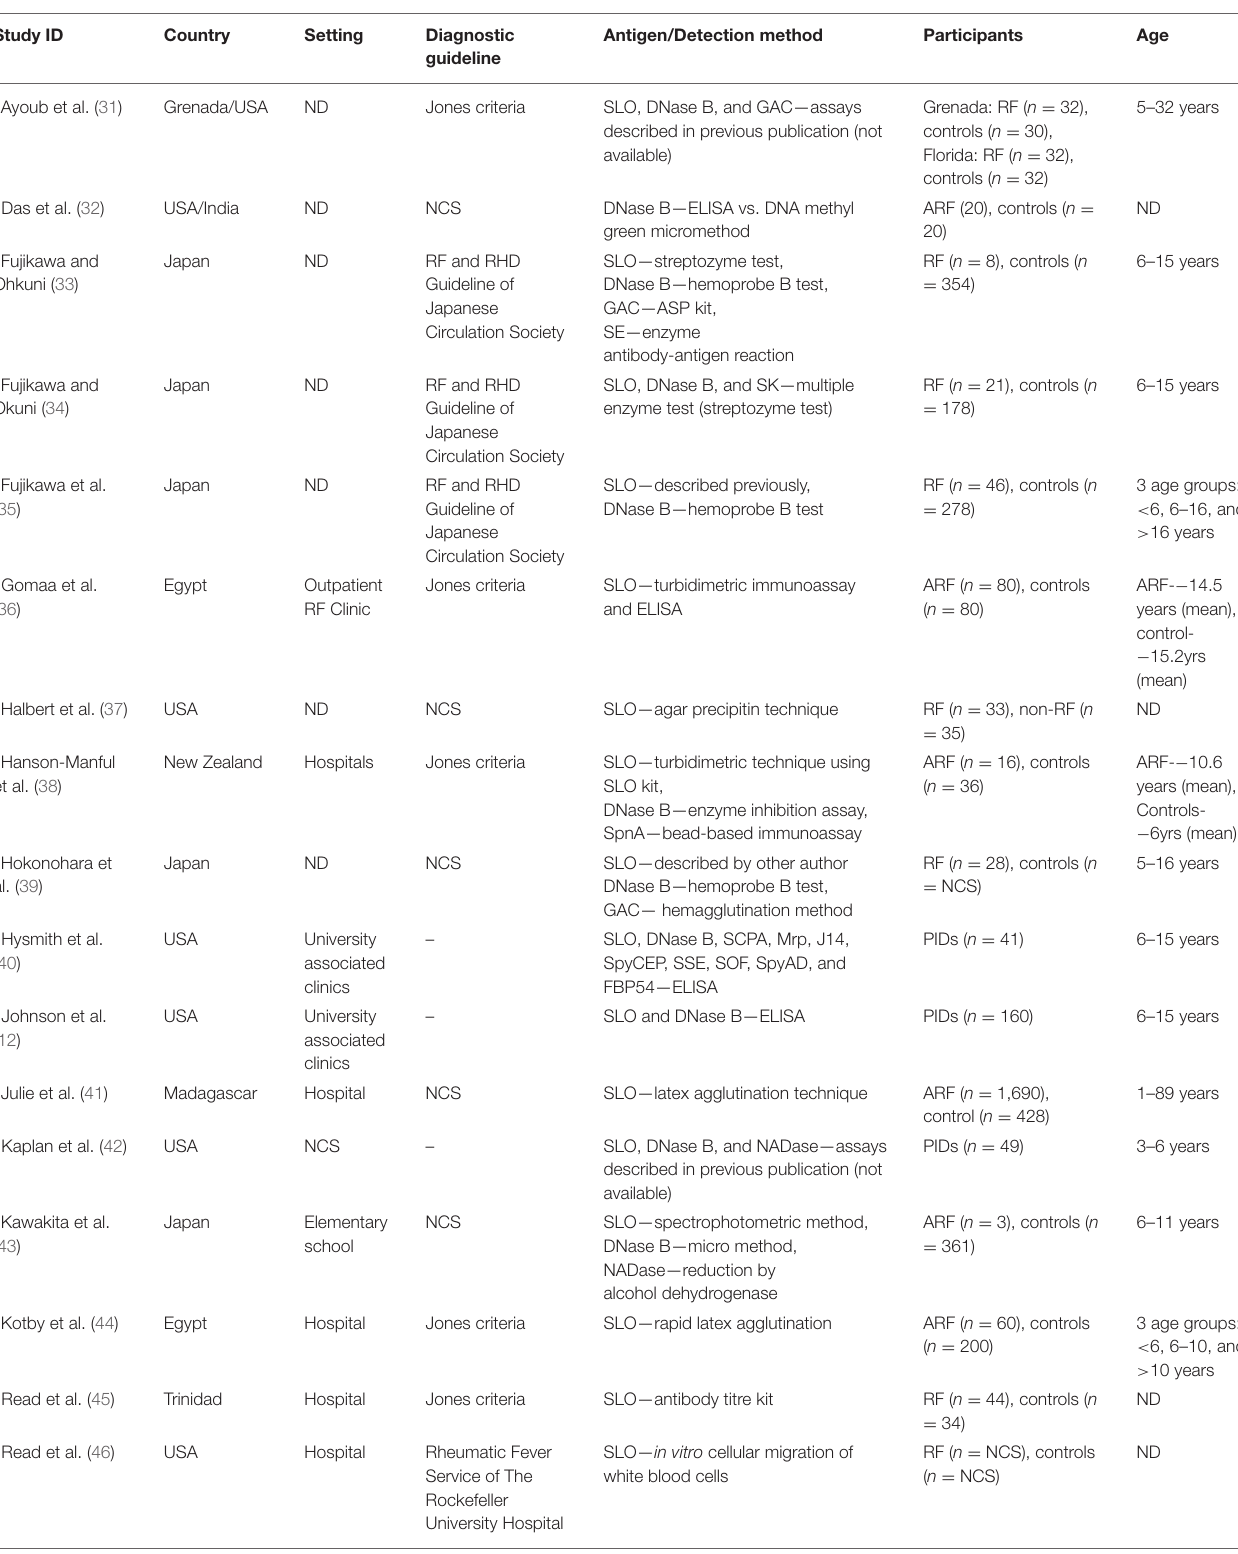
TABLE 1 | Characteristics of included